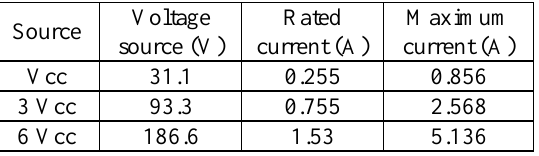
Table 2: Parameters of independent DC sources.